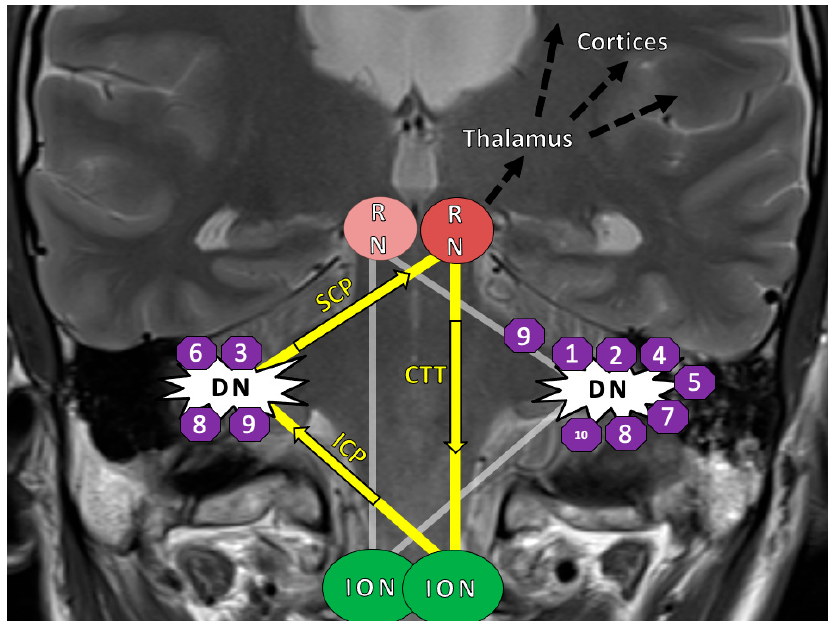
Figure 1. Disease model with lesion sites: The Guillain–Mollaret-triangle (yellow) and its unidirectional course of inhibitory fibers that ascent from the dentate nucleus (DN) to the contralateral red nucleus (RN) and then descend ipsilateral to the inferior olivary nucleus (ION). The bilateral overlapping Guillain–Mollaret triangles (yellow and grey) together form a “tilted star of David configuration” [5]. The numbers in octagons indicate the position of the operative lesions in Patients 1–10 of this study, who ultimately developed a HOD appearance on MRI. In bilateral lesions, octagons are shown on both sides. Fibers of the GMT, which is also called the dentato–rubro–olivary-pathway, overlap with dentato–thalamo– cortical pathways proceeding into both hemispheres (black arrows) [10]. Abbreviations: GMT = Guillain–Mollaret-triangle; HOD = hypertrophic olivary degeneration; SCP = superior cerebellar peduncle; ICP = inferior cerebellar peduncle; RN = red nucleus; CTT = central tegmental tract; DN = dentate nucleus; ION = inferior olivary